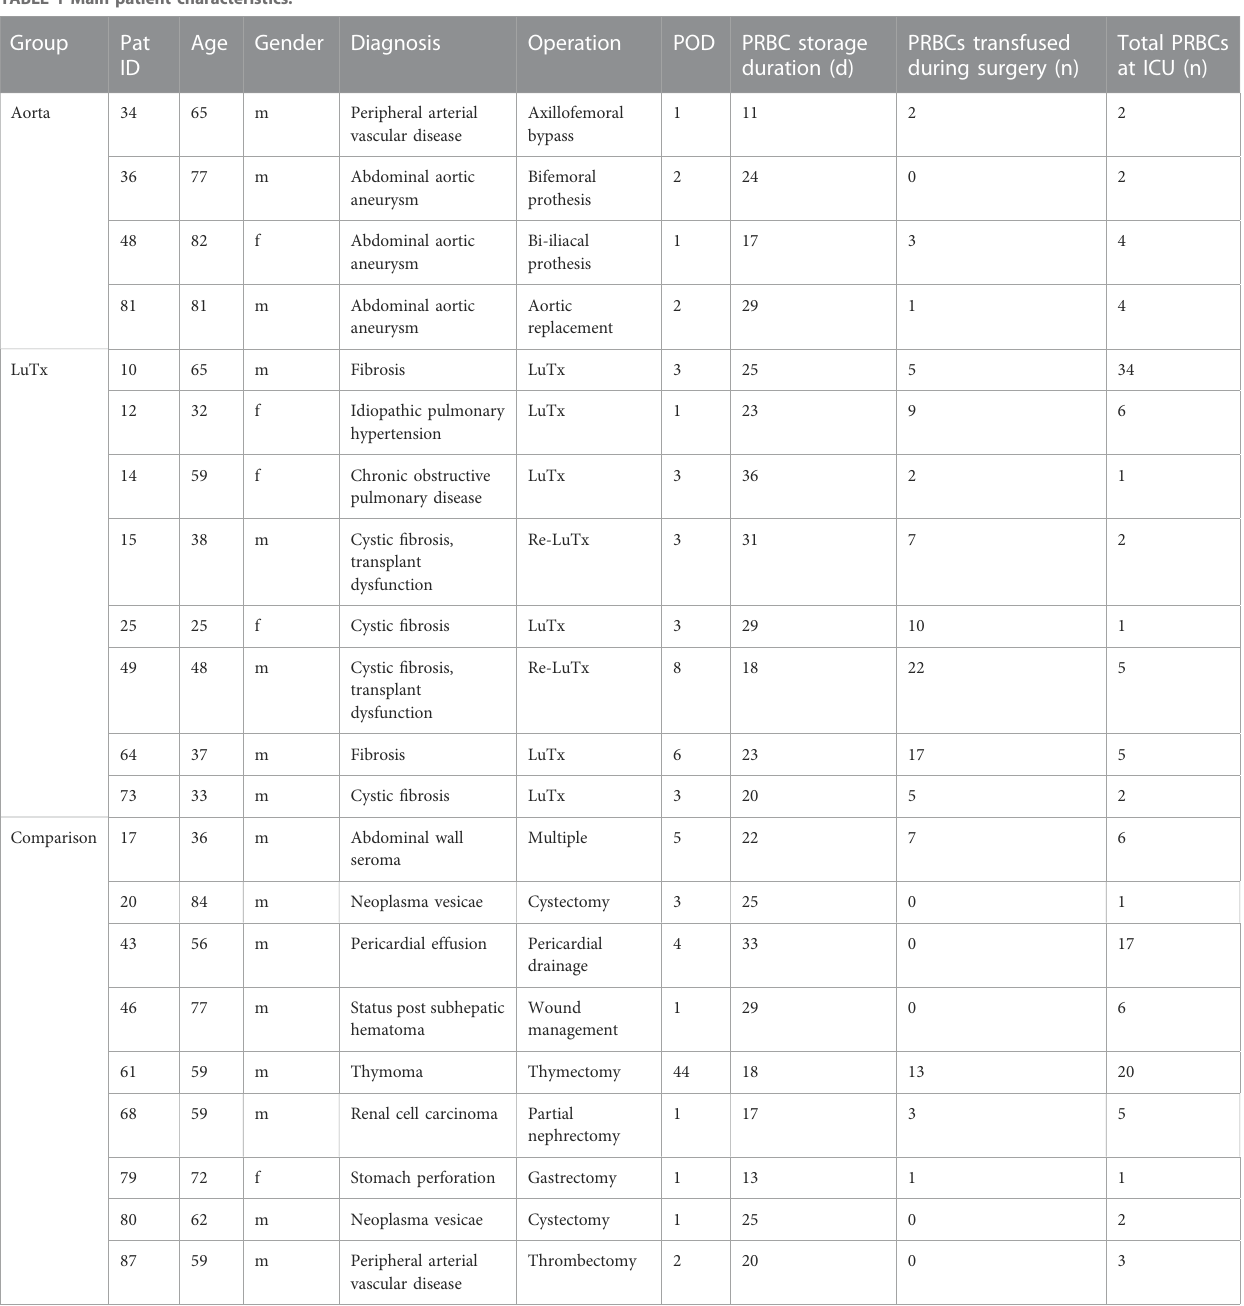
TABLE 1 Main patient characteristics. Group Pat ID